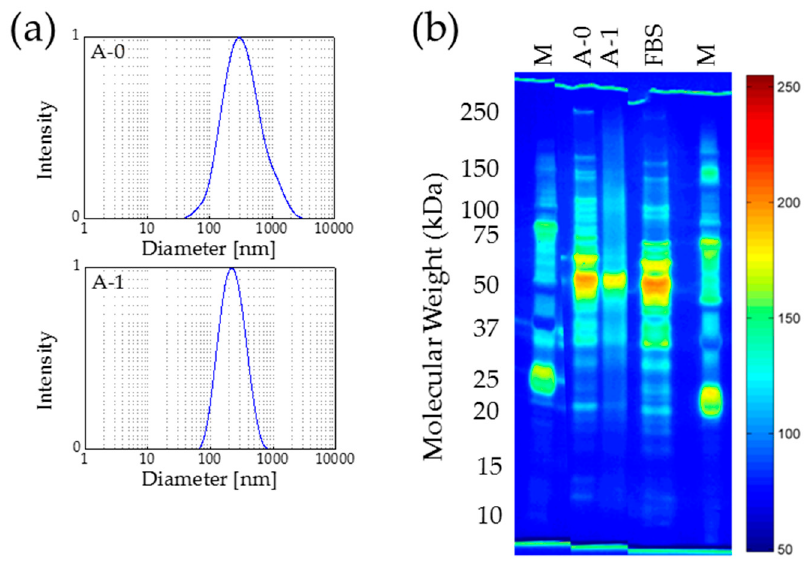
Figure 4. Autoclaving of protein-coated nanoparticles affects the protein corona dramatically. ( a ) DLS measurements show that the hydrodynamic diameter of the protein-coated nanoparticles decreases during treatment ( b ) Proteins are degraded during autoclaving demonstrated by gel electrophoresis (silver staining and false color representation). n = 3, M—protein size marker.